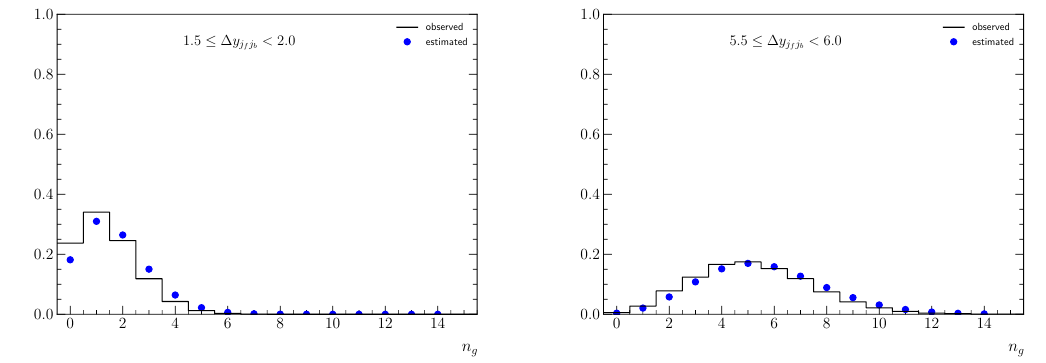
Figure 3. Number of additional gluon emissions n g for two di(cid:11)erent rapidity spans between the extremal jets. The estimates are based on Poisson distributions with mean values taken from the (cid:12)t function in (cid:12)gure 2 for (cid:1) y j = 1 : 75 and (cid:1) y j = 5 : f j b f j b